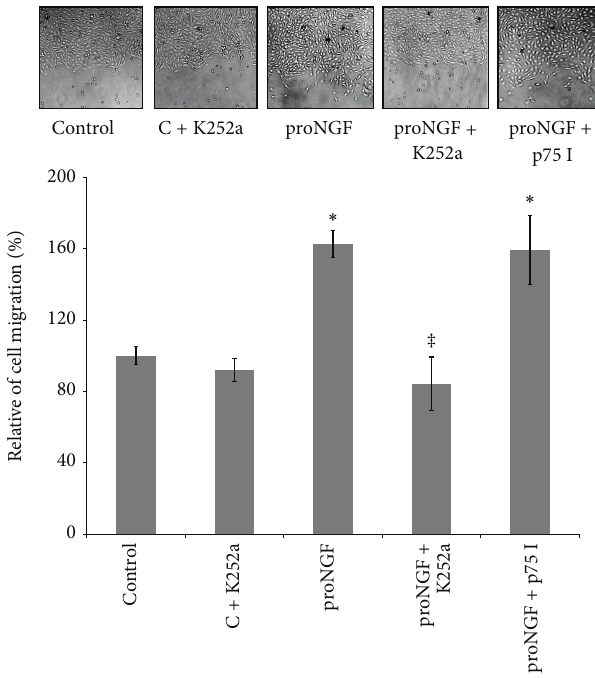
Figure 6: Inhibiting TrkA prevents proNGF-mediated retinal endothelial cell migration. BRE cells were grown to confluence and then scratched using a standard cell scrapper. Cells were switched to serum free medium and treated with mutant proNGF (50ng/mL) in the presence or absence of either TrkA receptor antagonist, K252a (0.1 𝜇 M), or p75 inhibitor (20 𝜇 M). Representative micrographs for wounded BRE cells are shown after 18 hours of various treatments. Statistical analysis showed that proNGF increased mean cell migra- tion by 1.98-fold compared to the control group. This effect was blocked by the specific TrkA receptor antagonist (K252a) but not with p75 inhibitor ( ∗,‡ statistically significant compared to control and proNGF groups, resp., ( 𝑃 < 0.05 ), 𝑛 = 6